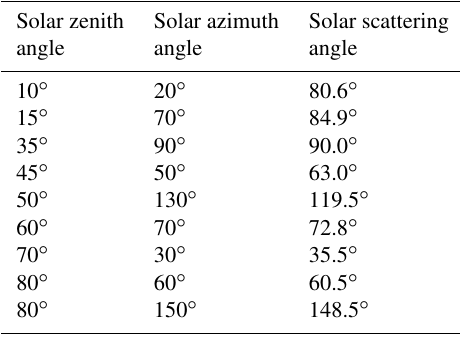
Table 1. Solar zenith angles, solar azimuth angles, and solar scat- tering angles used in the test